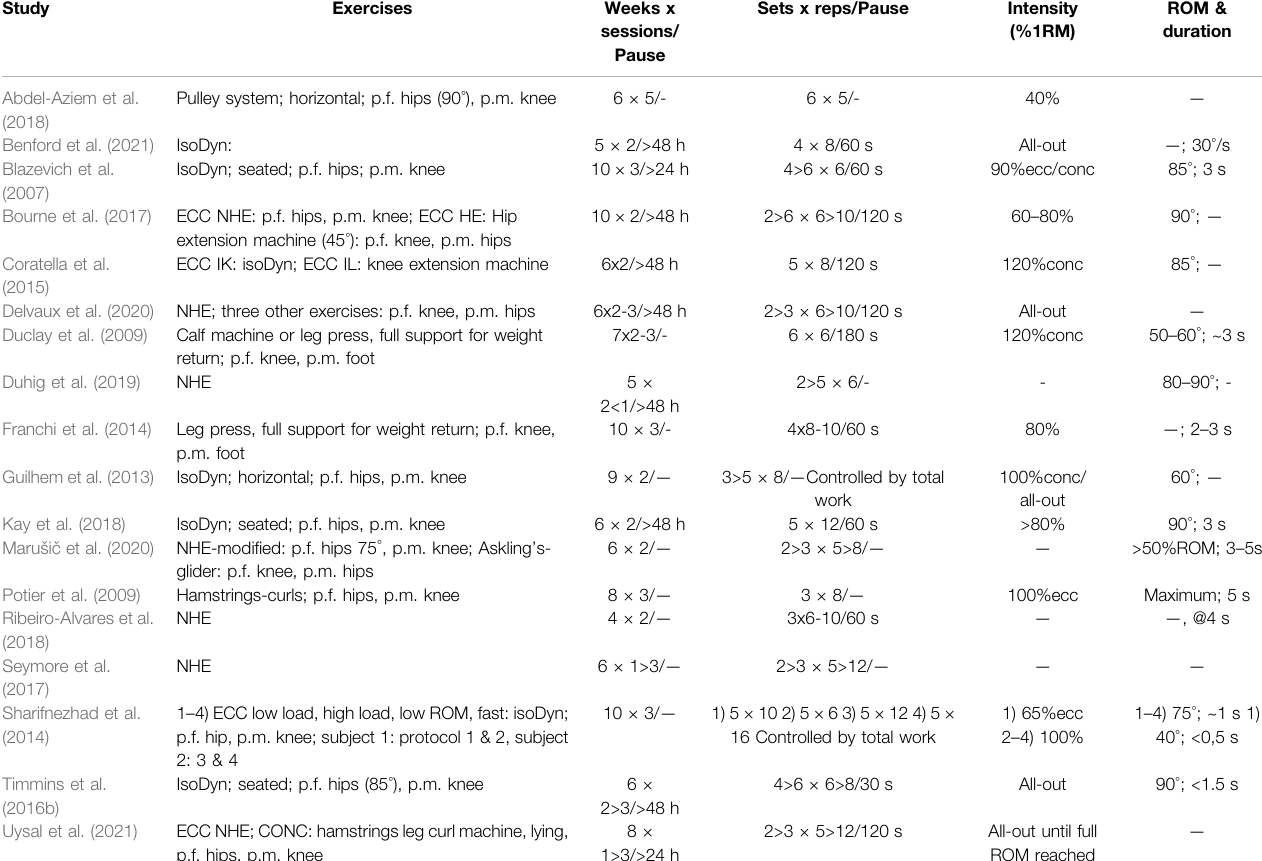
TABLE 3 | Eccentric training